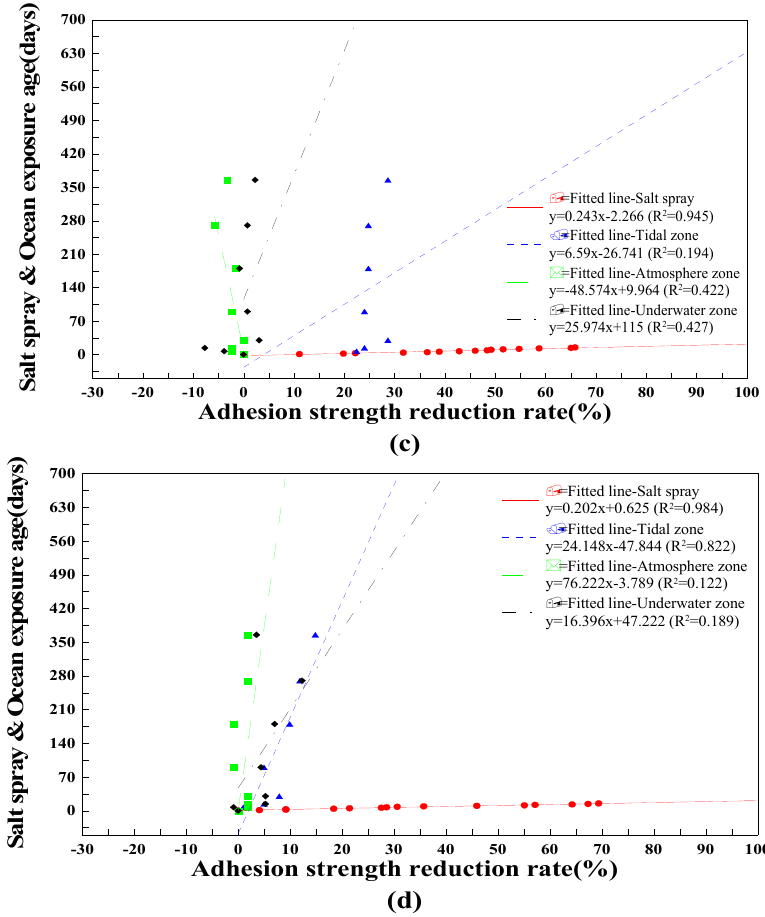
Figure 5. Comparison of corrosion rate of ( a ) MS, ( b ) MC, ( c ) TP, ( d ) EP.